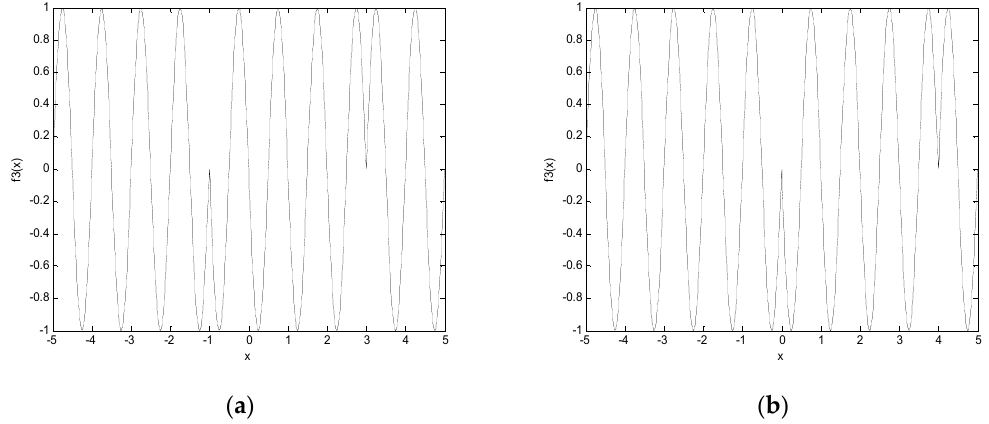
( ) f x with 1 p = : ( a ) 3